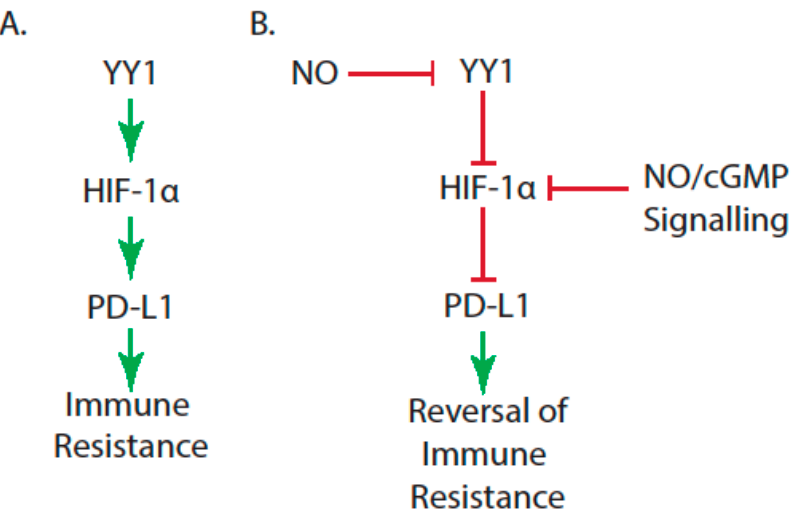
Figure 2. NO, HIF-1 α , and YY1 in the reversal of immune resistance in hypoxic conditions. ( A ) YY1 contributes to the stability and accumulation of HIF-1 α , leading to the upregulation of PD-L1 and tumor cell immune resistance. ( B ) NO inhibits YY1, thus reversing HIF-1 α accumulation, the expression of PD-L1, and immune resistance. NO / cGMP signaling also inhibits HIF-1 α accumulation in a mechanism involving calpain, thus reversing the expression of PD-L1 and immune